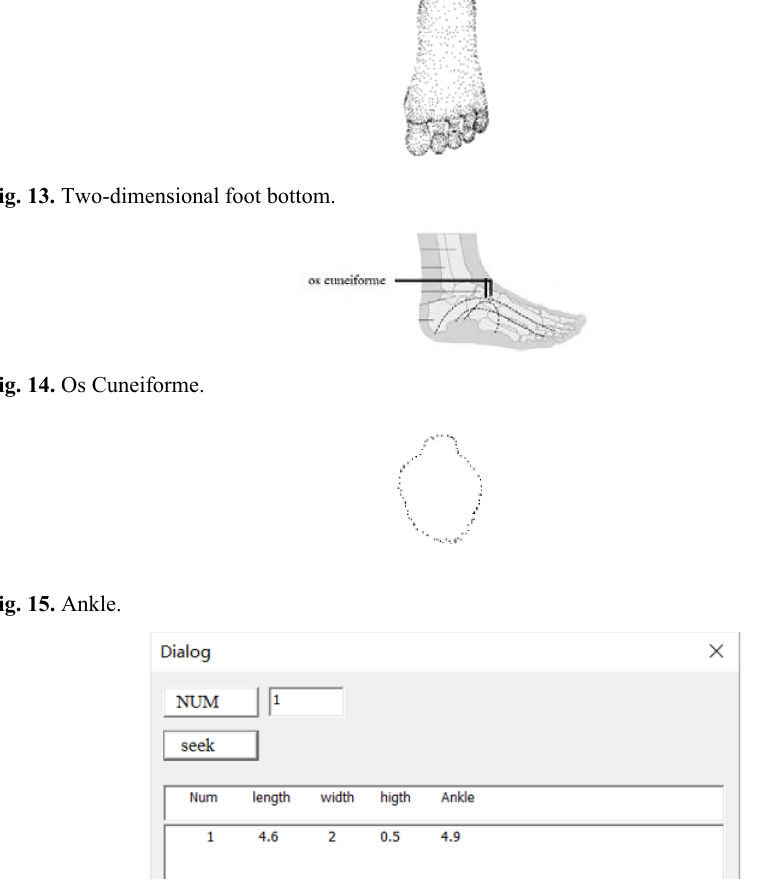
Fig. 12. Complete plantar surface.